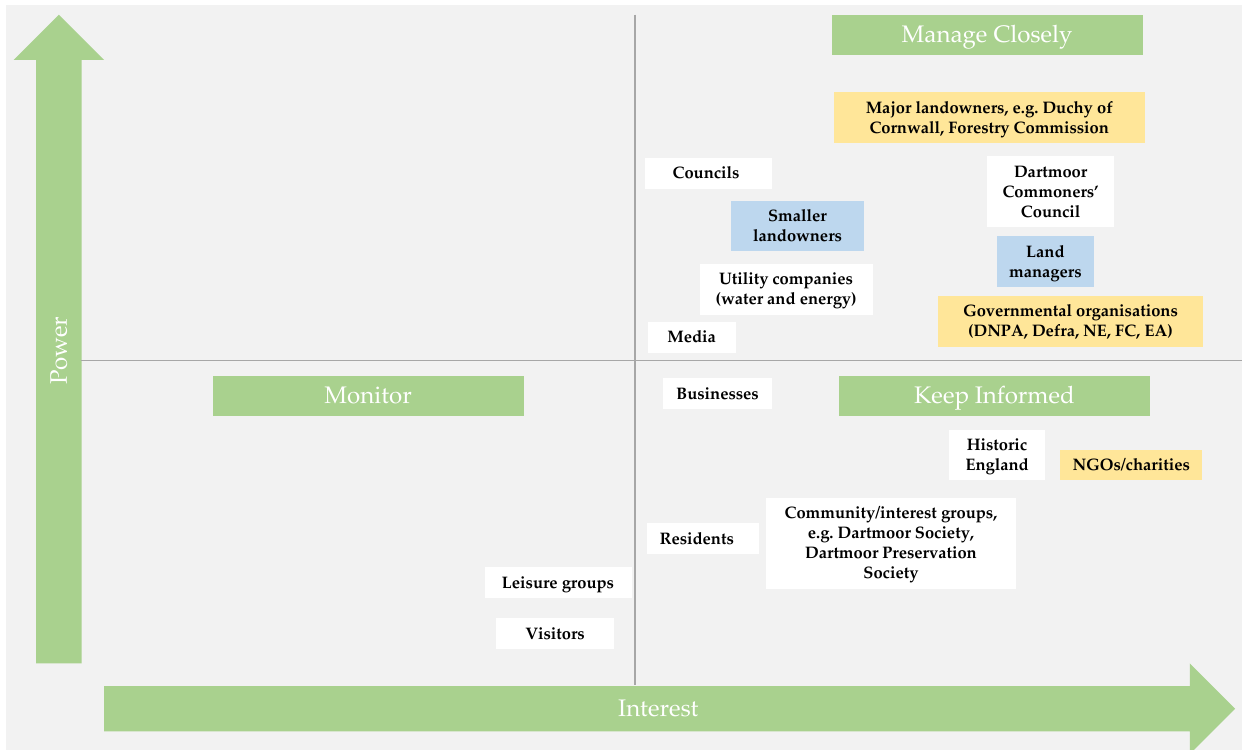
Figure 2. A stakeholder matrix based on axes of influence and interest mapped the stakeholders of the Dartmoor National Park, UK. Interviewees are representative of the blue (farmers) and yellow (key informants) stakeholder